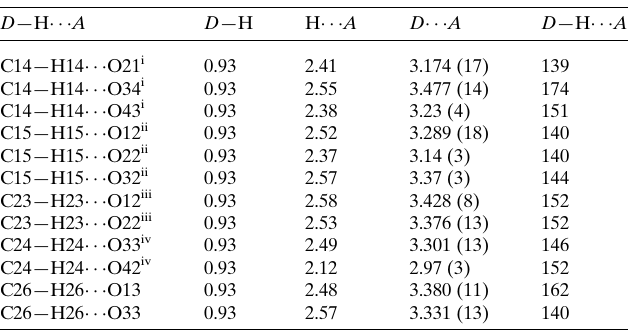
Table 2 Hydrogen-bond geometry (A˚ , (cid:3) ) for (III).